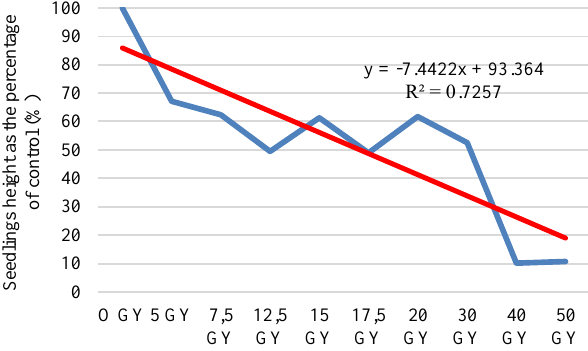
Figure 4. Growth reduction effect of the fast neutron on Ocimum basilicum